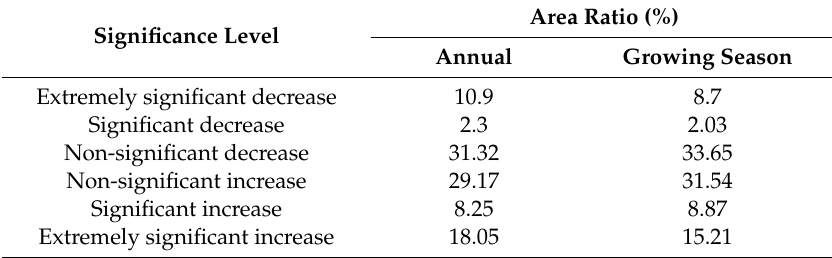
Figure 8. Annual ( a, b ) and growing season ( c, d ) variation trends of SPEI with the significance test. Table 5. Area ratios of the SPEI occupied by different trends.